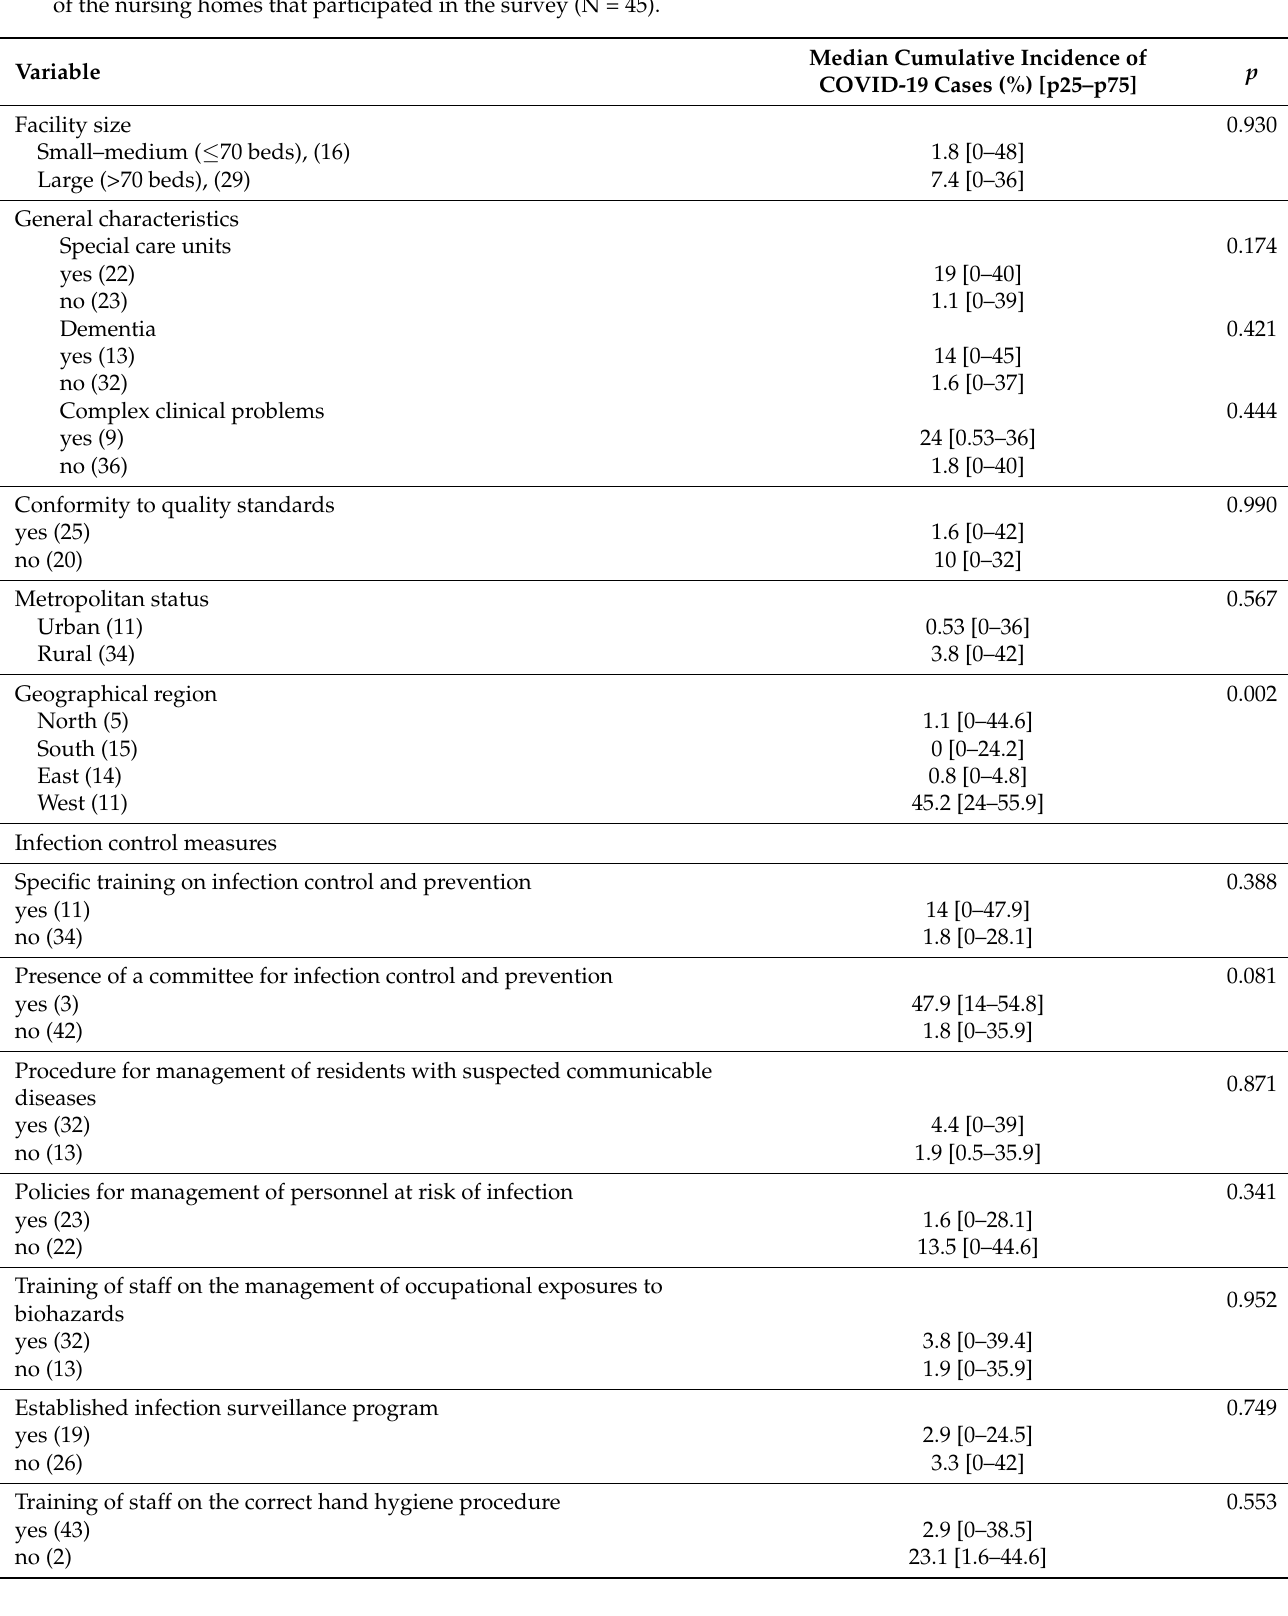
Table 2. Association analyses between median cumulative incidence of COVID-19 cases among residents and characteristics of the nursing homes that participated in the survey (N =